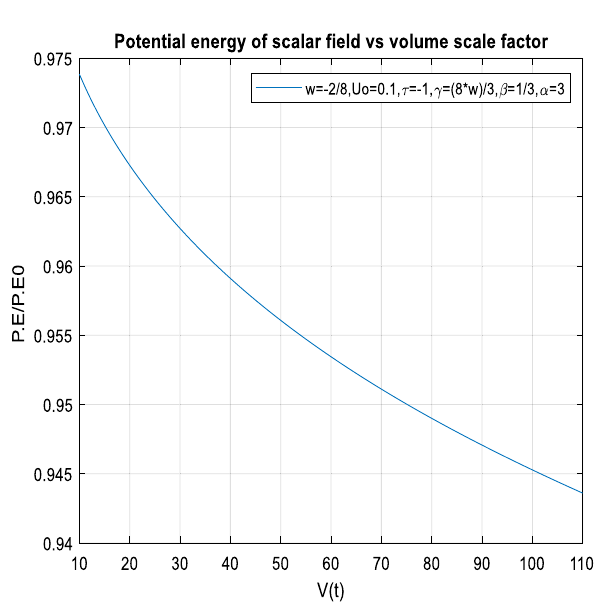
Fig. 27 Graph for potential term in fields; w = − 2 − 1 ; γ = 8 w